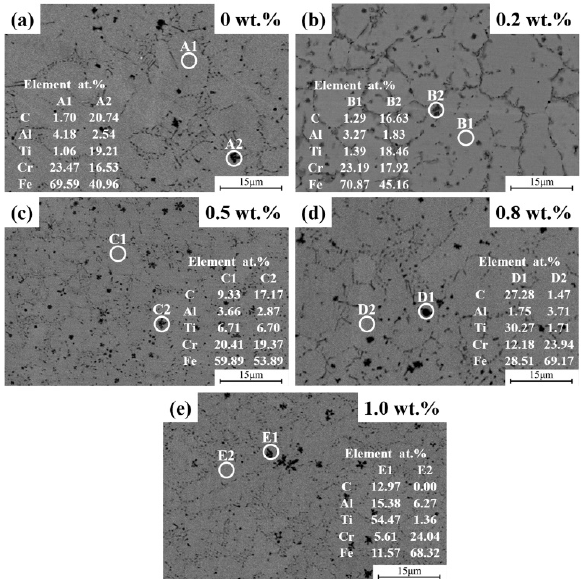
Figure 5. SEM microstructures and EDS analysis results of the coatings with different Y 2 O 3 additions: ( a ) 0 wt.% and EDS of point A1, A2, ( b ) 0.2 wt.% and EDS of point B1, B2, ( c ) 0.5 wt.% and EDS of point C1, C2, ( d ) 0.8 wt.% and EDS of point D1, D2, ( e ) 1.0 wt.% and EDS of point E1,